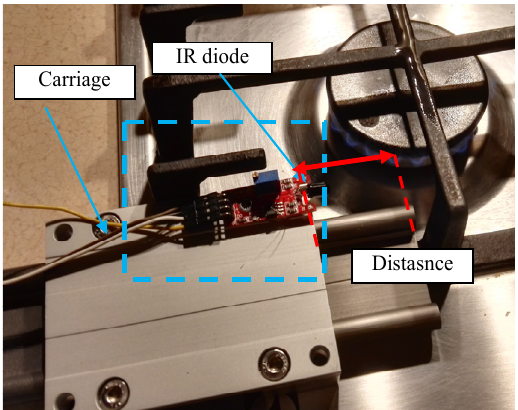
Figure 18. The application of the IR diode for the temperature measurement.